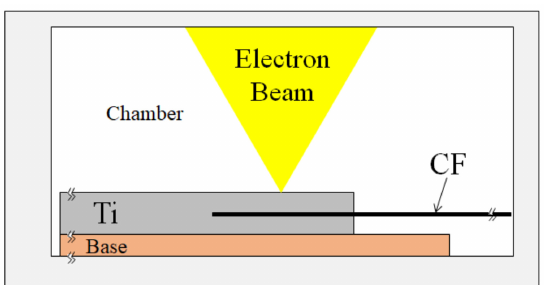
Figure 2. Schematic diagram of focused EB spot welding of CF with molten Ti under vacuum